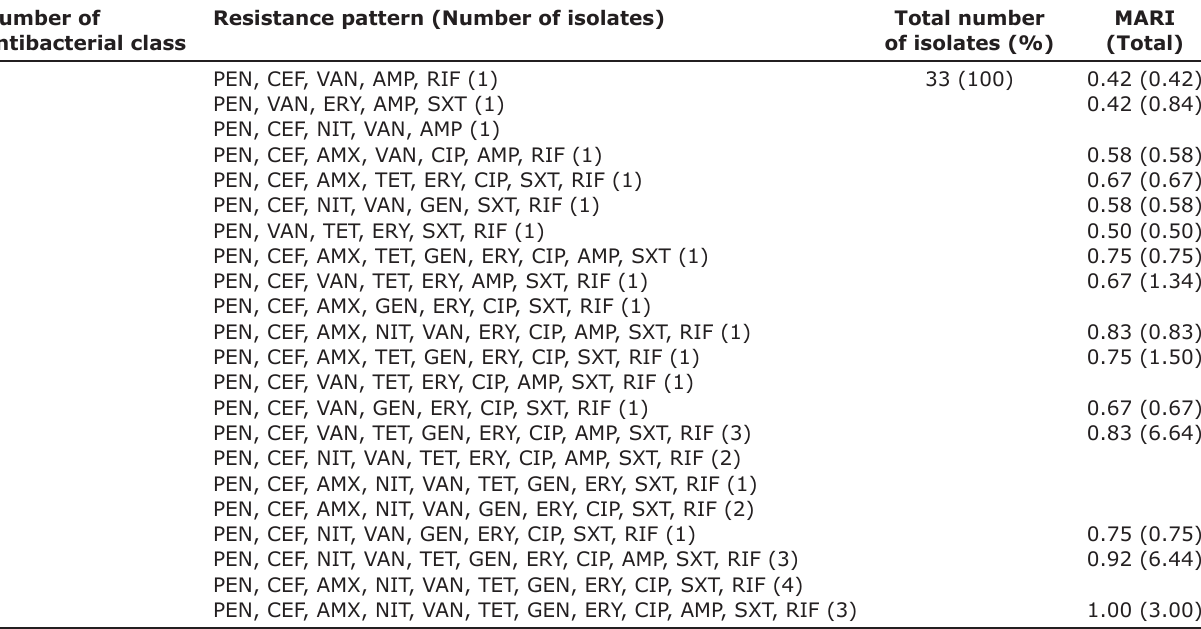
Table-3: Multiple antibacterial resistance patterns and indices of 33 Listeria isolates from raw beef marketed in Enugu State Southeast Nigeria. Number of antibacterial class